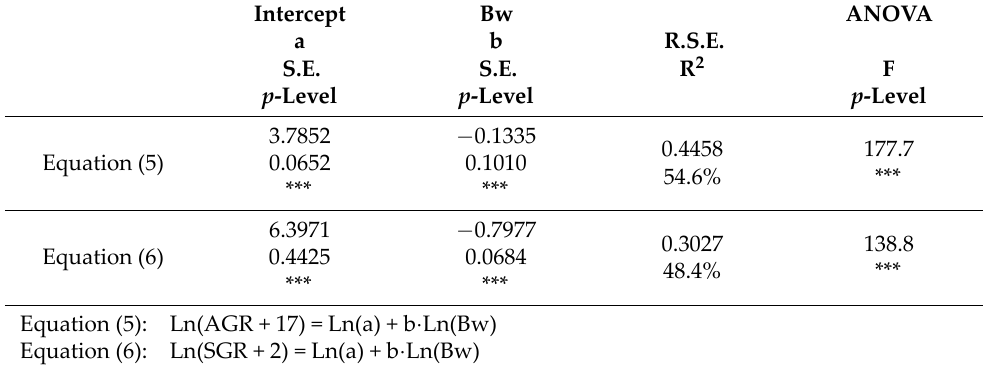
Table 3. Simple linear regression for AGR and SGR as dependent variables from Bw values greater than 400 mg. S.E., standard error; R.S.E., residual standard error; and R 2 , coefficient of determination. Intercept Bw a p ‑Level